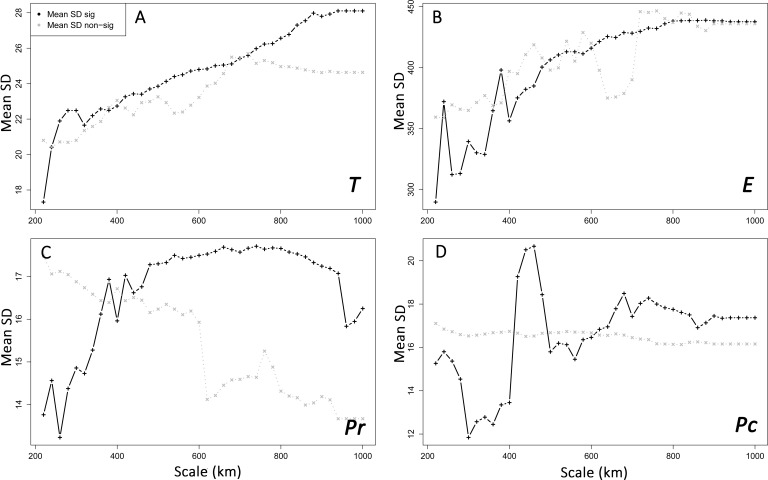
Spatial heterogeneity (mean standard deviation, SD) of environmental features in areas with supported and non-supported resistance hypotheses through Mantel tests with increasing scales.Mean SD: mean standard deviation. T, mean minimum temperatures (A); E, elevation (B); Pr, high pine densities as barriers (C); Pc, high pine densities as corridors (D). sig: significant, non-sig: non-significant.